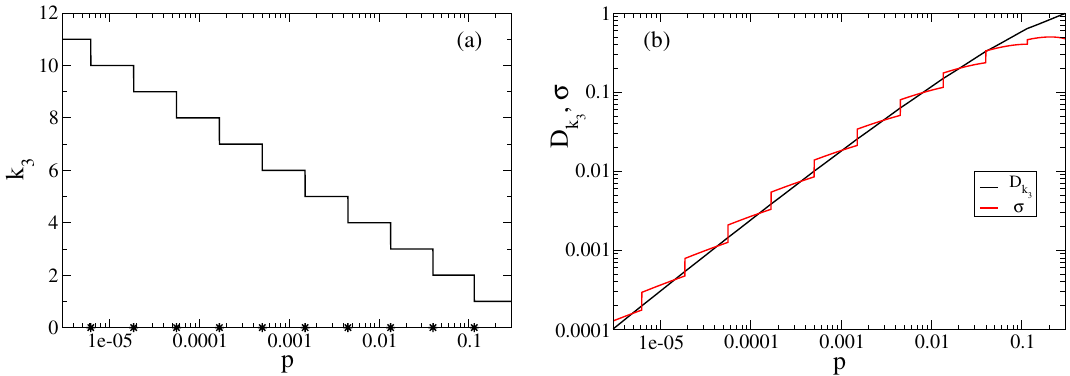
( 3 k , . . . , 3 ) , as functions of p . ( a ) The number of Figure 2. Properties of the optimal nested strategy, m = 3 , is a piece-wise constant decreasing function of p with k 3 , with k 3 given by Eq. (13) and µ stages, k = = discontinuities at the probabilities indicated with stars on the horizontal axis. ( b ) The expected value, D k 3 ( m , p ) (black curve), and standard deviation, σ( m , p ) (red curve), of the number of tests per individual stay close to one another and increase monotonically with p